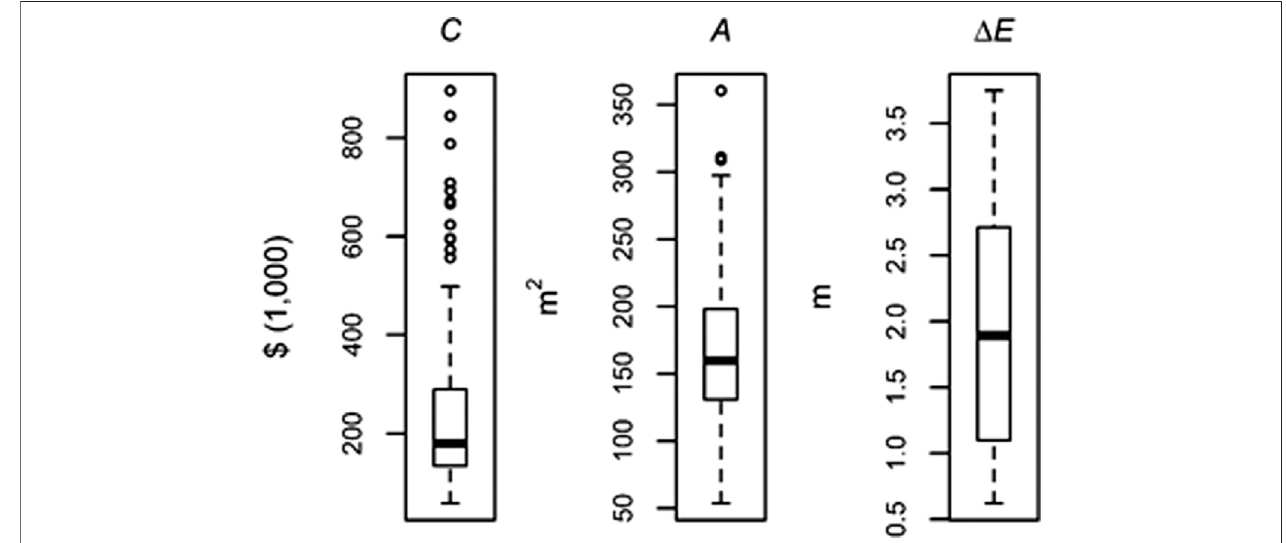
FIGURE 1 | Boxplots of continuous variables for elevated homes in Louisiana, 2005 – 2015, cost normalized to 2015 dollars.